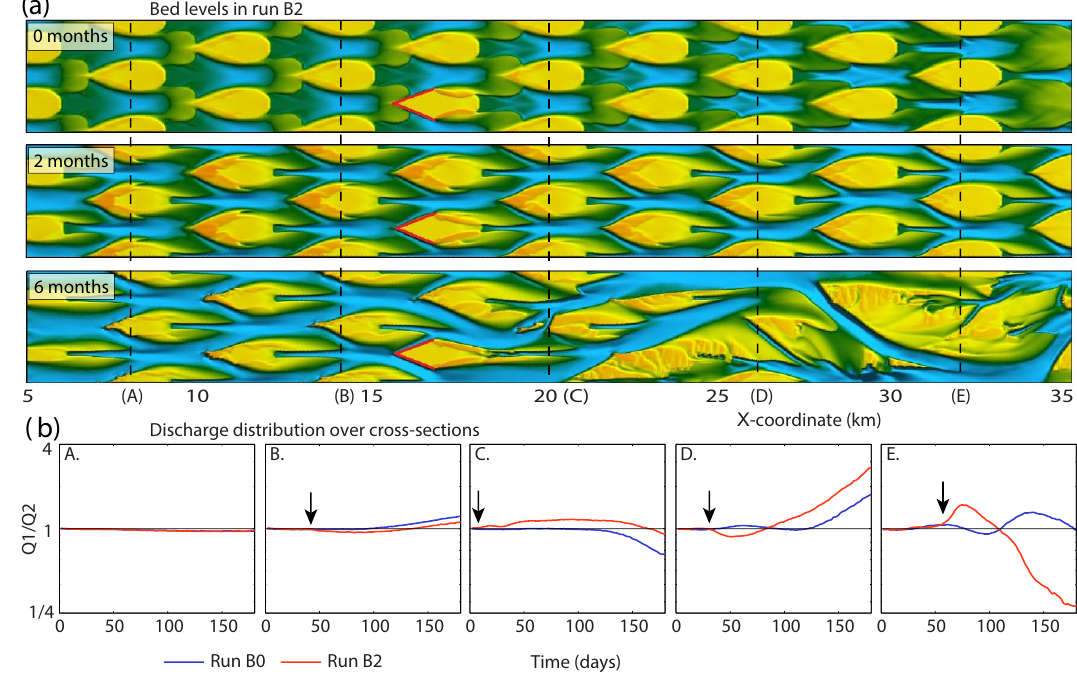
Figure 10. Evolution of the braided channel network and bar pattern in Run B2 with bar protection: (a) time series of the bed level and (b) discharge distribution with Q 1 the discharge through the northern branches. The black arrows indicate the position of the propagating